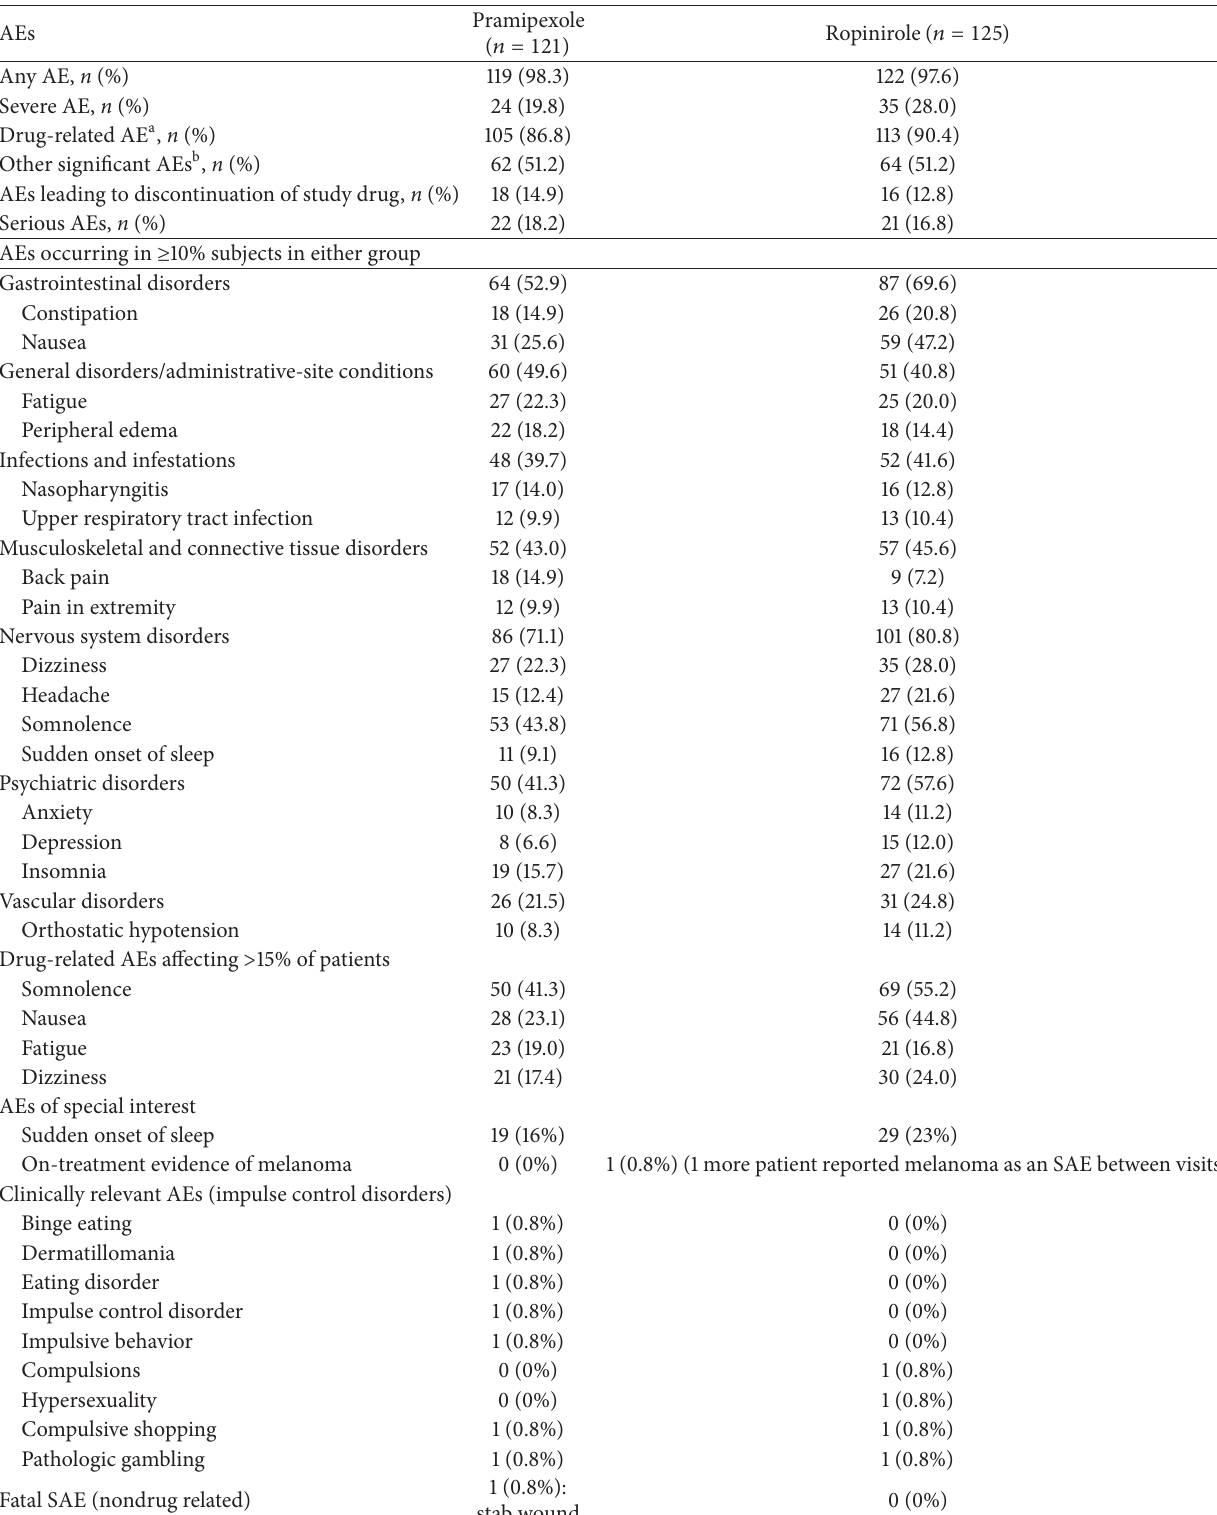
Table 6: Summary of adverse events (AEs; treatment-emergent irrespective of relationship to treatment, unless described specifically as